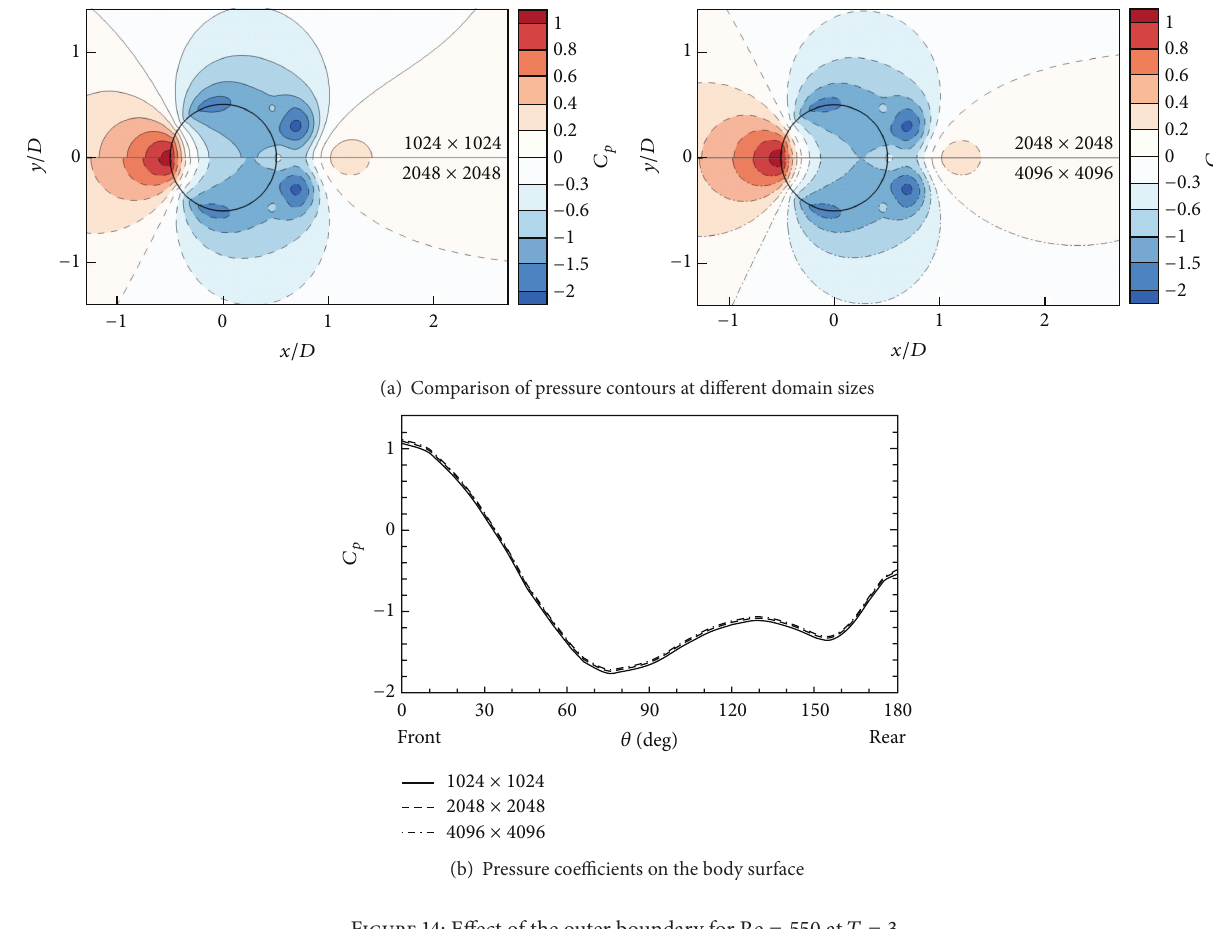
Figure 14: Effect of the outer boundary for Re = 550 at 𝑇 = 3 .